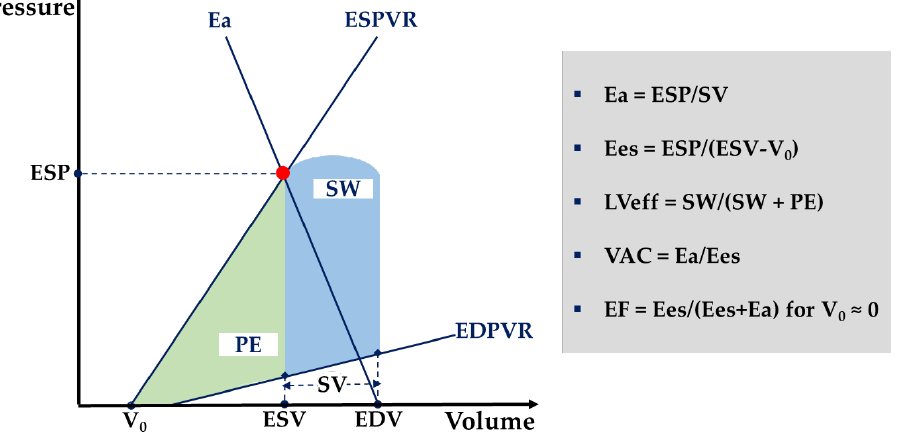
Figure 4. A schematic illustration of ventricular–arterial coupling (VAC). The left ventricle (LV) is characterized by the end-systolic and end-diastolic pressure–volume relationship (ESPVR and EDPVR). The end-systolic LV elastance (Ees) is the slope of the ESPVR line. V 0 , the LV end-systolic unstressed volume, is the intercept of ESPVR with the volume axis. The arterial system is character- ized by the arterial elastance (Ea), i.e., the slope of the Ea line that connects the end-diastolic volume (EDV) with the end-systolic point (red dot). End-systolic coordinates are the end-systolic pressure (ESP) and the end-systolic volume (EDV). Stroke work (SW) (blue area) is maximum for Ea/Ees of 1 and a corresponding ejection fraction (EF) of 50%. LV metabolic efficiency (LVeff) is maximum for Ea/Ees close to 0.5 and a corresponding EF of 66%. PE, end-systolic potential energy (green area). Adapted after Hayashida et al. [80].